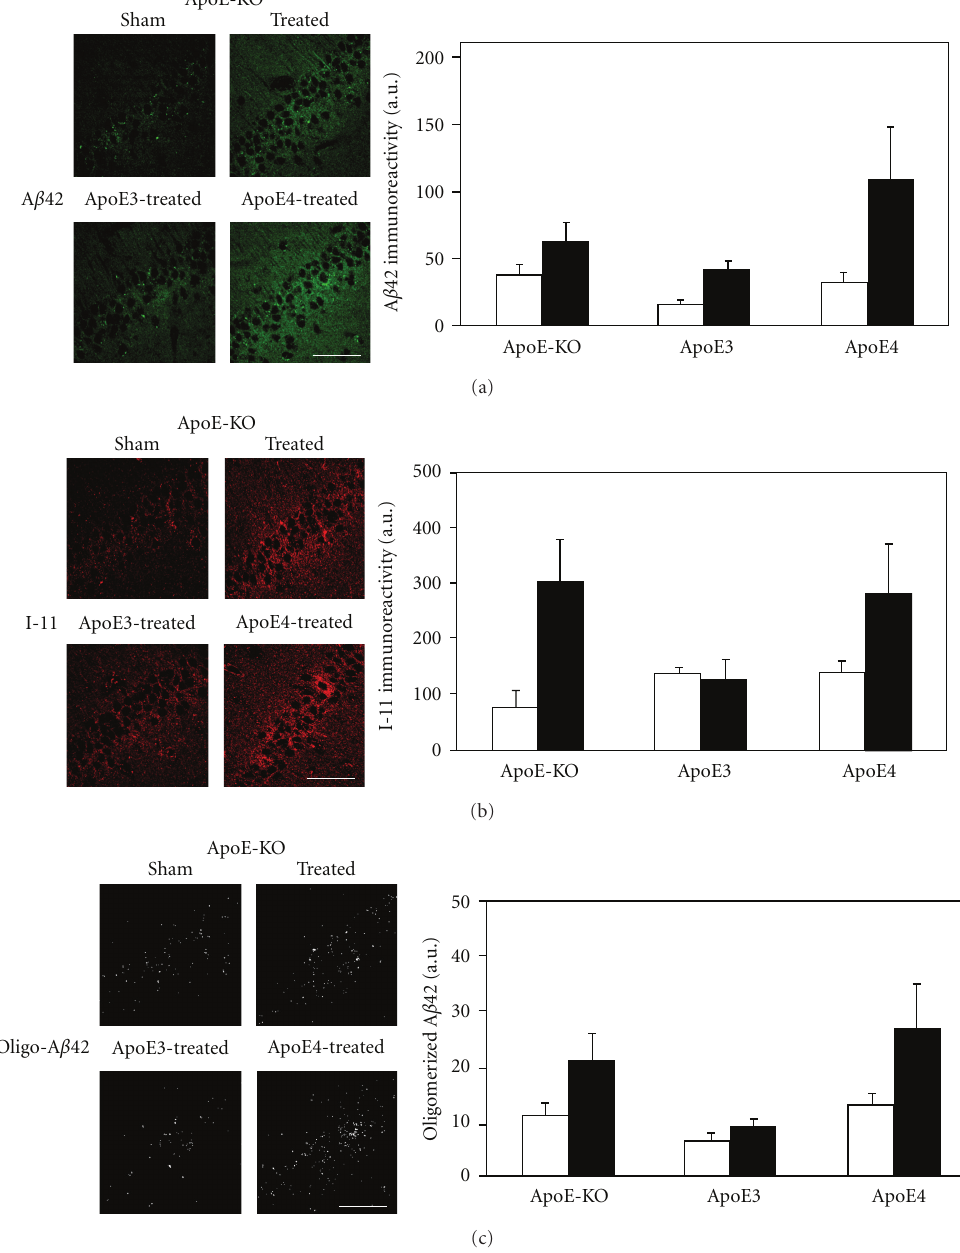
Figure 2: The e ff ects of apoE3, apoE4, and apoE deficiency on the levels of A β 42 and oligomerized A β 42 in CA1 hippocampal neurons following inhibition of neprilysin. ApoE3-, apoE4- and apoE-deficient male mice were injected i.c.v. with the neprilysin inhibitor thiorphan; or sham-treated for 10 days, after which their brains were excised and subjected to anti-A β 42 and anti-I-11 immunfluorescence, as described in “Materials and Methods.” (a) Representative coronal sections of sham- and thiorphan-treated apoE-deficient mice (upper row) and thiorphan-treated apoE3 and apoE4 mice (lower row) immunostained with anti-A β 42 are shown on the left (bar = 50 μ m). Quantification of the density of A β 42 staining (mean ± SEM; n = 4–5 mice/group) in the CA1 neurons of the indicated mice is shown on the right (empty and filled bars correspond, resp., to sham- and thiorphan-treated mice). P < . 02 for the e ff ects of treatment on the three mouse groups by two-way ANOVA. (b) Representative confocal images of I-11 of the CA1 area of the indicated mouse groups treated for 10 days with thiorphan (left) and quantification (right) of the density of I-11 staining (mean ± SEM; n = 4–5mice/group). Empty and filled bars correspond, respectively, to sham- and thiorphan-treated mice and P < . 02 for the e ff ect of treatment by two-way ANOVA. (c) Representative masked oligo-A β 42 images of the CA1 area of the indicated mouse groups treated for 10 days with thiorphan (left) and quantification (right) of the density of oligo-A β 42 staining (mean ± SEM; n = 4–5mice/group). Empty and filled bars correspond, respectively, to sham- and thiorphan-treated mice and P < . 02 for the e ff ect of treatment by two-way